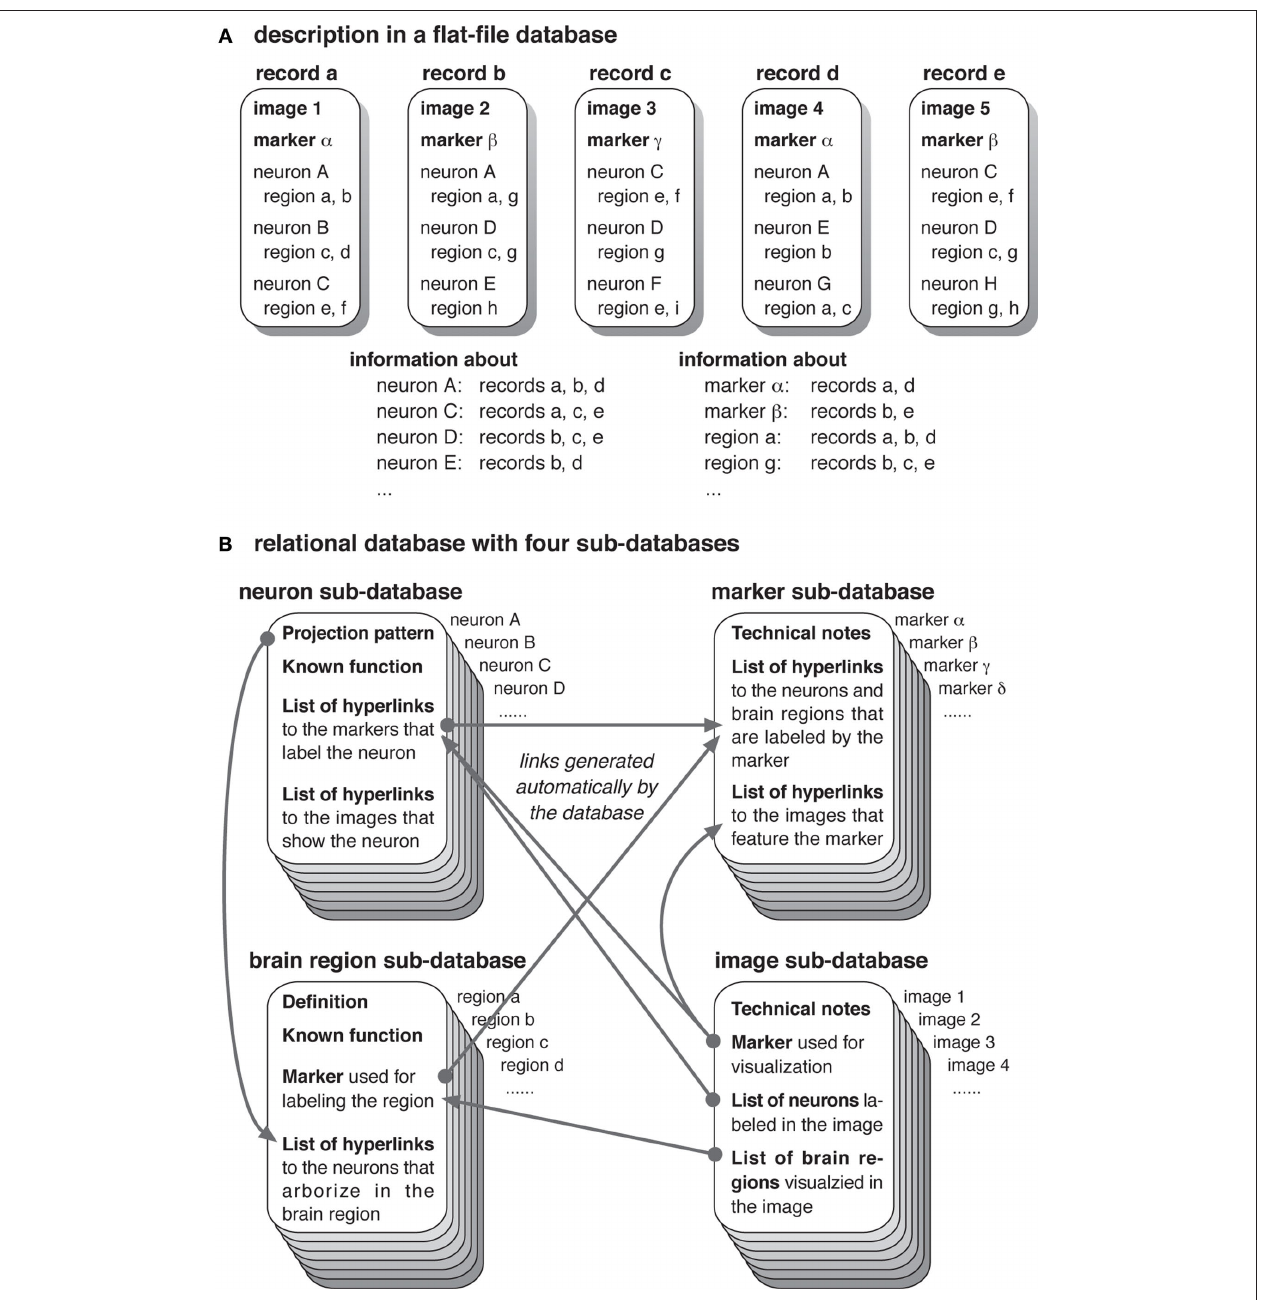
type, marker, or brain region is scattered in the database, causing redundancy and possible inconsistency. (b) An example of a relational database with the sub-databases dedicated for the records of neurons, markers, brain regions, and images. Information about the complete projection patterns of the neurons, definition, and known functions of the brain regions, and technical details of the molecular markers and image preparation, are documented in respective records. When a new record is added, respective information in other records will automatically be